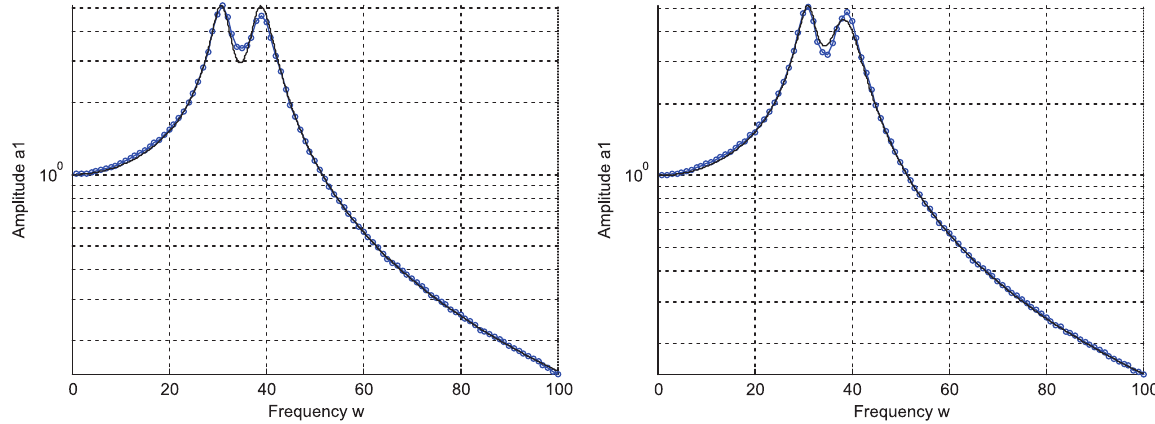
Fig. 5. Comparison of the amplitude-frequency curves of VDBG DVA by the analytical method (solid line) and the numerical one (circle line).